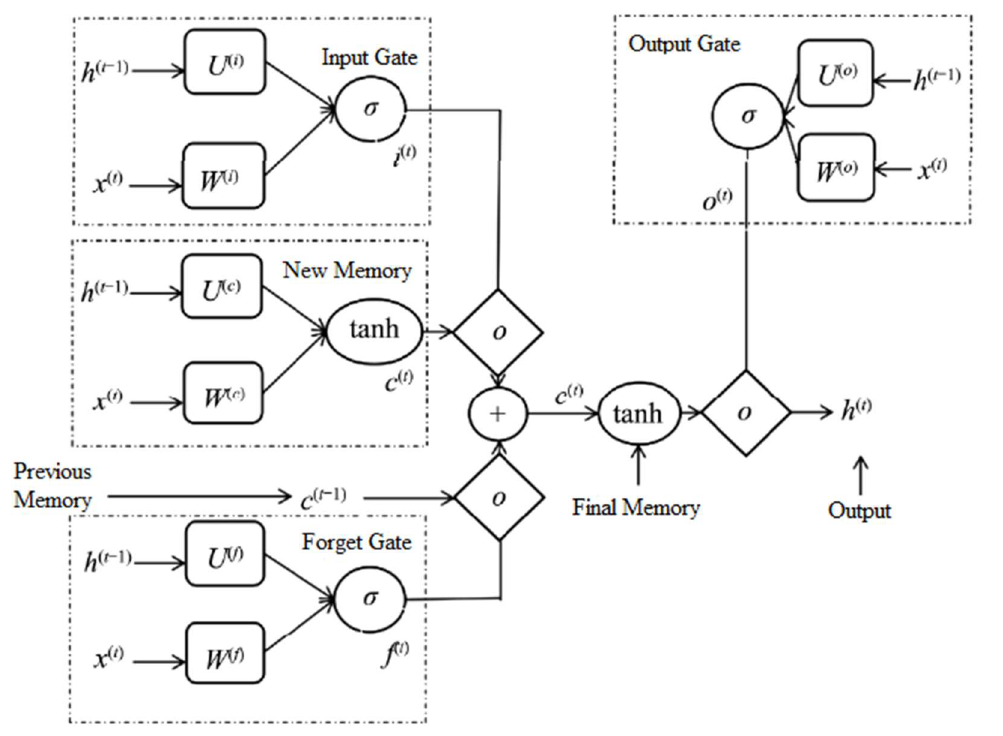
Figure 1. LSTM structure flow chart.